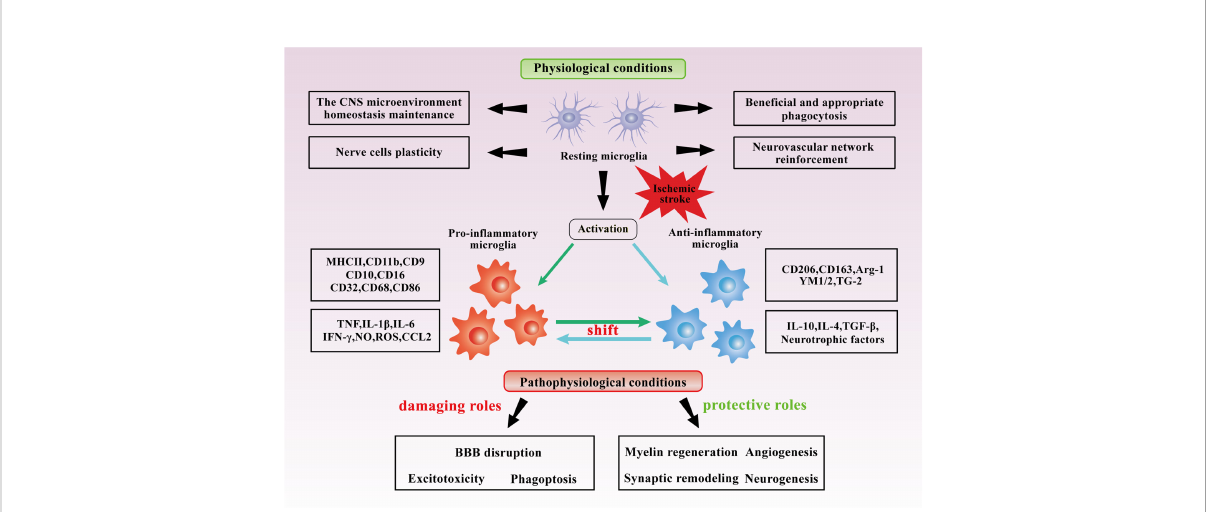
FIGURE 2 Dual roles of microglia in IS. Under normal conditions, microglia maintain the CNS microenvironment homeostasis and appropriately regulate the neurovascular network. Under the stimulation of cerebral ischemia, microglia are likely to be primarily activated to anti-in fl ammatory states at the early stages and pro-in fl ammatory states at the later stages, synthesize and secrete various cytokines and mediators. In IS, Microglia may be bene fi cial in angiogenesis, myelin regeneration, synaptic remodeling, and neurogenesis in IS, but they may also be detrimental in BBB disruption, excitotoxicity, and